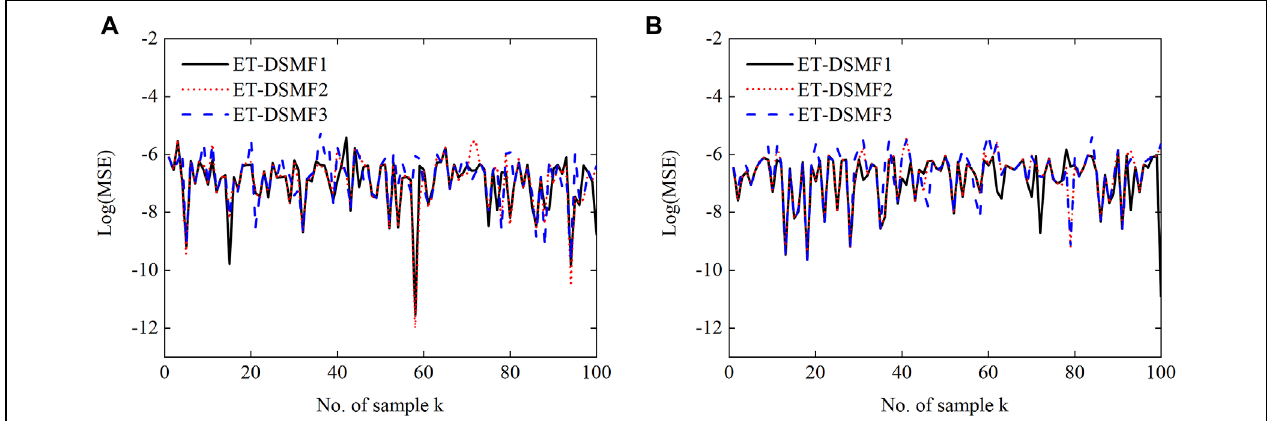
FIGURE 11 | Log(MSE) between the true and estimated values of c-phase at bus 4 for the ET-DSMF algorithm: (A) the real part of the voltage and (B) the imaginary part of the voltage.